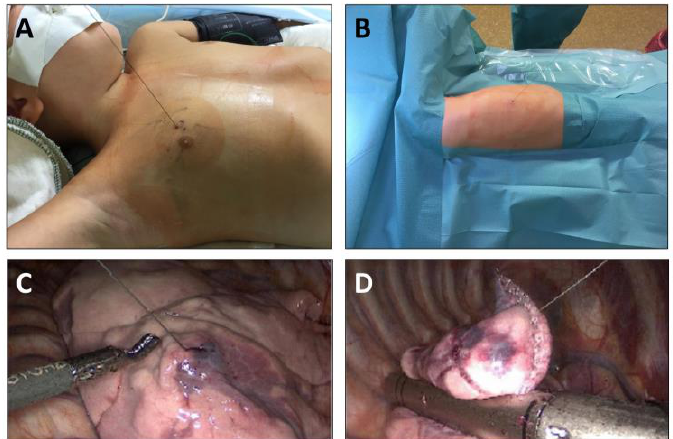
Figure 2. Thoracoscopic resection of lung nodules following CT-guided labeling. ( A ) Intraoperative aspect after removal of the dressing (left-sided upper-lobe nodule); ( B ) intraoperative aspect after positioning and preparation of the patient; ( C ) intraoperative view during thoracoscopy: localization of wire entering the lung parenchyma; ( D ) atypical lung resection of the labeled area using the endo-stapler.